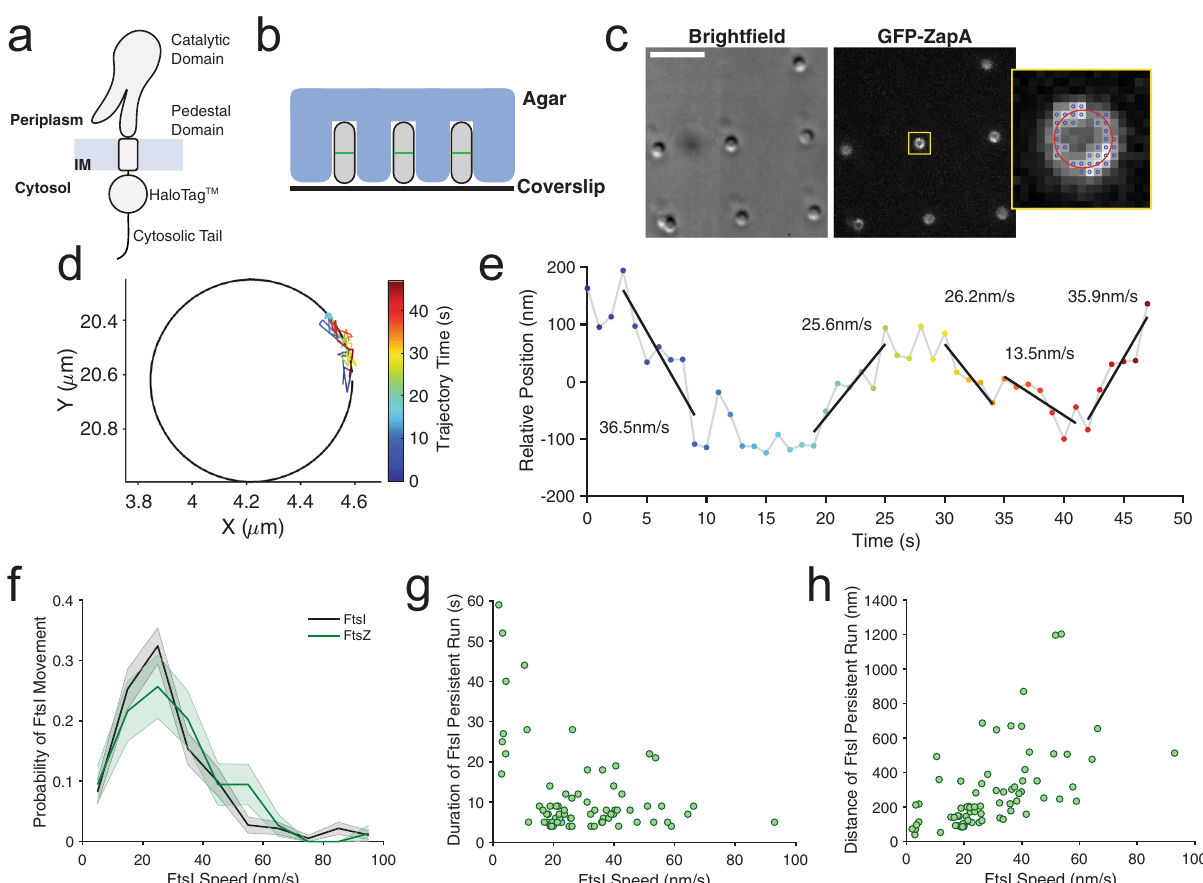
Fig. 4 Experimental characterization of FtsI directional motion. a Schematic of the functional sandwich fusion of FtsI. The Halo tag is inserted between residues 18 and 19 of FtsI, immediately before the fi rst residue of the transmembrane (TM) domain. b Diagram of individual E. coli cells loaded in microholes made by nanopillars. c Bright fi eld and fl uorescence images of microholes loaded with E. coli cells labeled with GFP-ZapA and Halo-FtsI SW fusion proteins. Inset shows the zoomed image of one cell in the yellow box. Blue circles indicated the pixels used for the fi t of ZapA-GFP circle. Scale bar is 5 µ m. Experiment repeated 18 times with similar results. d Circle- fi tting of GFP-ZapA image super-imposed with the trajectory of a single FtsI molecule, colored in time. e the unwrapped trajectory from D with fi tted lines at each segment to extract directional speeds, persistent run duration and distance. f Distributions of FtsI ’ s directional movement speeds ( n = 77 trajectories, 74 directional events) and FtsZ ’ s treadmilling speed (from Yang et al. 13 ). For the purpose of this study, we only plotted the fast-moving population of FtsI that follows FtsZ ’ s treadmilling and leave out the slow-moving population of FtsI that we show to be independent of FtsZ ’ s treadmilling 13 . Both FtsI ’ s and FtsZ ’ s histograms were bootstrapped 100 times to provide the shaded standard error bars (mean ± S.E.M.). A two-sample Kolmogrov – Smirnov test comparing the two datasets showed no difference in their distributions ( p = 0.1852). g Dependence of the duration of FtsI ’ s persistent run on its speed. h Dependence of the distance of FtsI ’ s persistent run on its